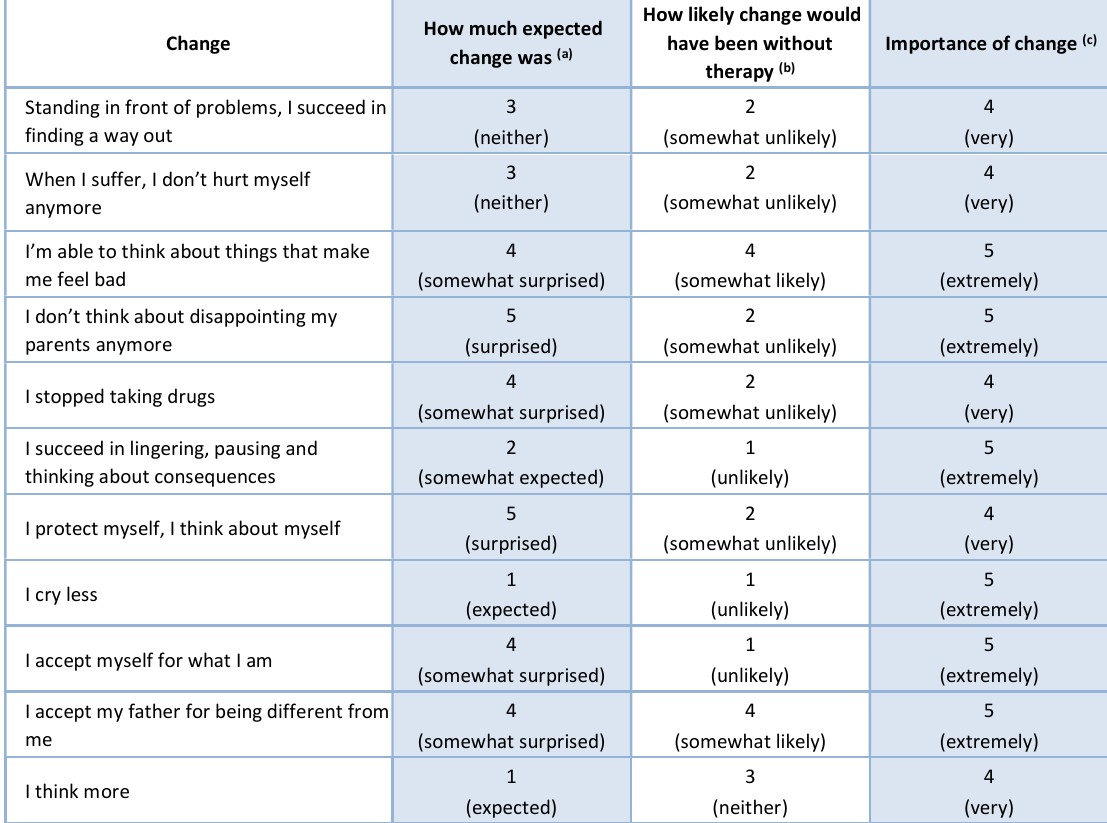
Table 4: Deborah’s Changes identified In the Change Interview Note. CI = Change Interview (Elliott et al.,